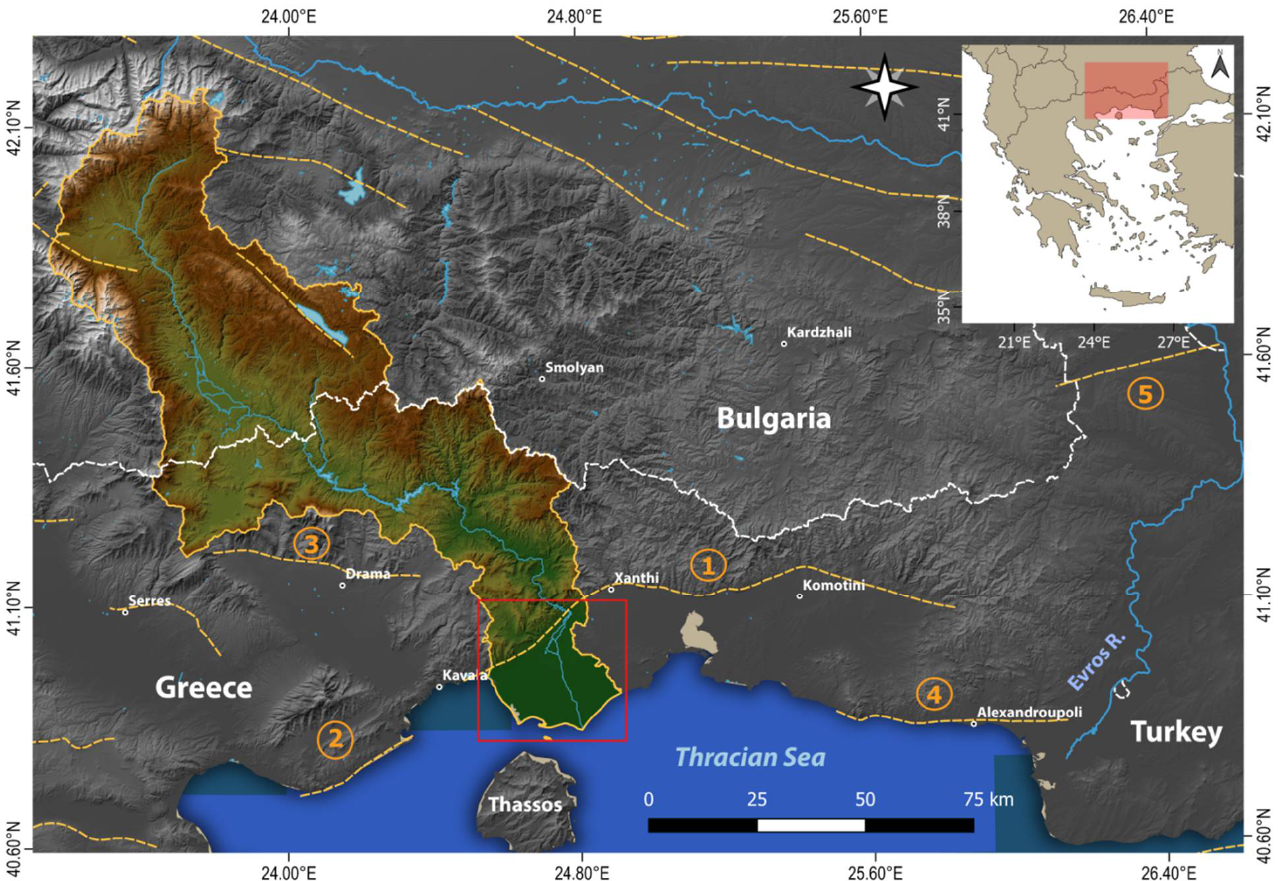
Figure 1. Geophysical map highlighting the Nestos River zone. The study area is indicated with the red square. (1) Kavala–Xanthi–Komotini fault, (2) Simvolo fault, (3) Drama fault, (4) Maronia fault, (5) Orestias–Mikri Doxipara. Fault zones from [41,42].